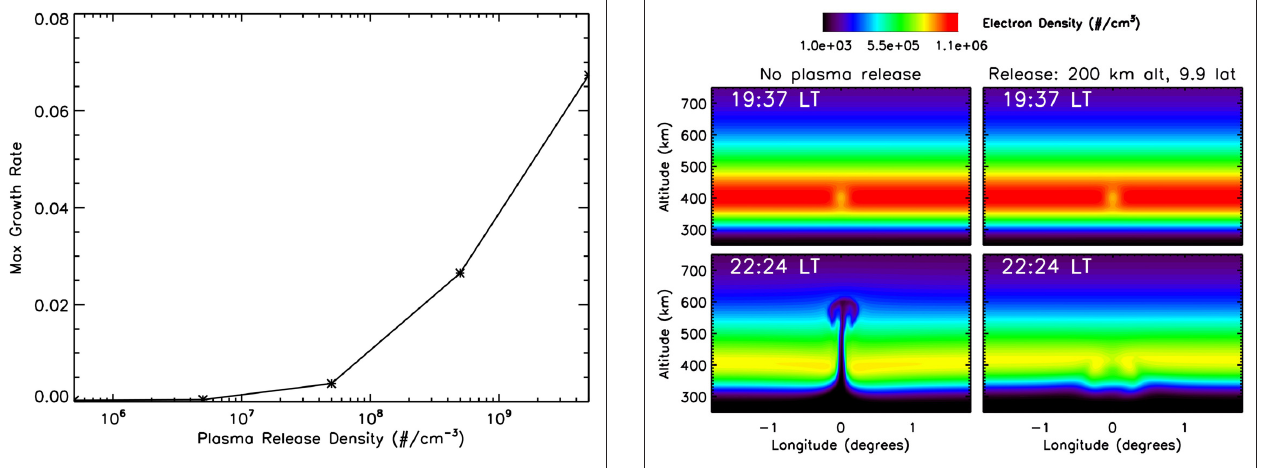
plasma release is not dense enough to suppress an ESF